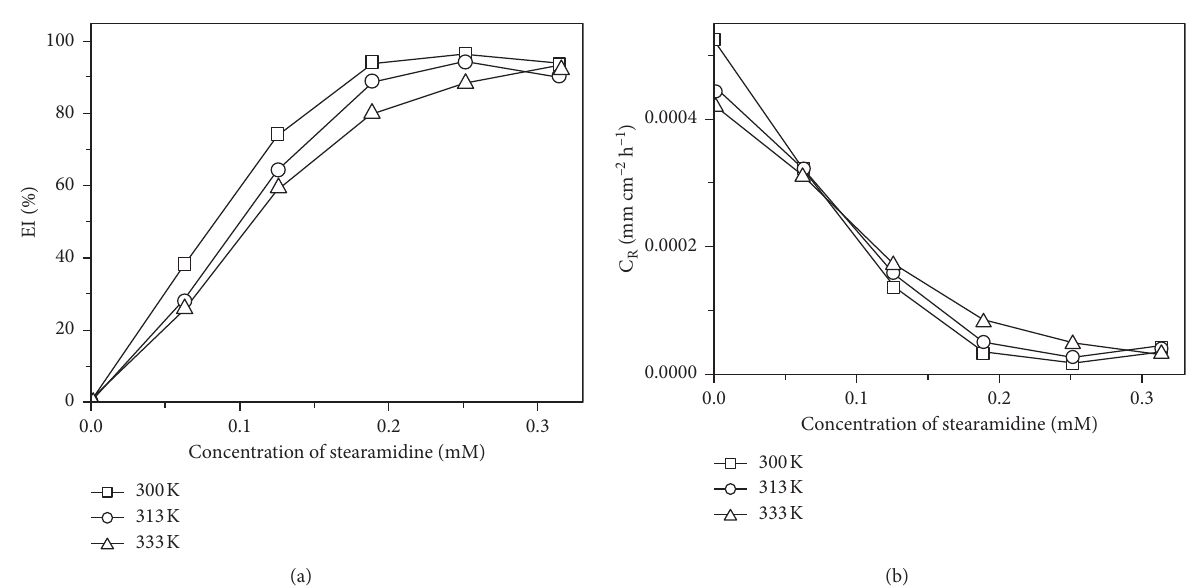
Figure 4: Inhibition efficiency (a) and corrosion rate (b) of copper as a function of the concentration of stearamidine in 3.0 wt.% NaCl solution at 300–333